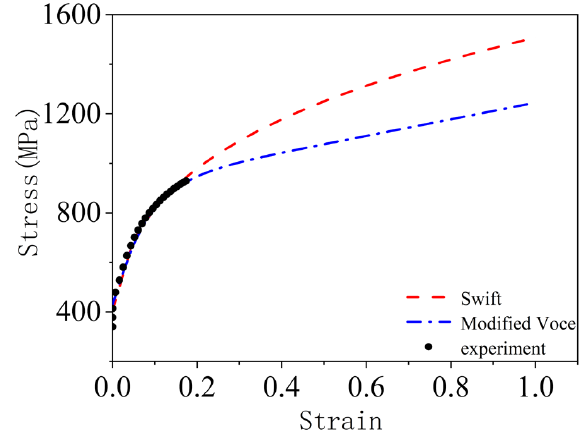
Figure 20. Stress-strain curve of material TRIP780.